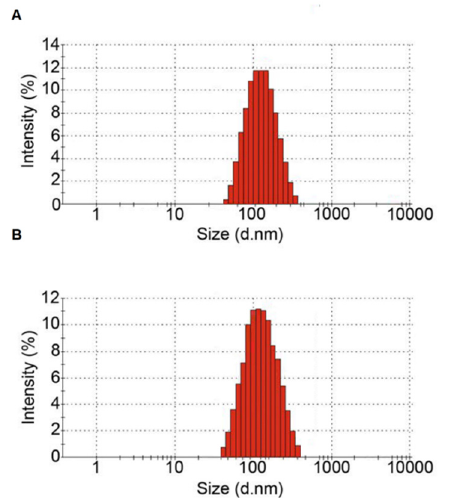
Figure 1. Distribution of extracellular vesicle size in ( A ) ADC samples and ( B ) SQCC samples.